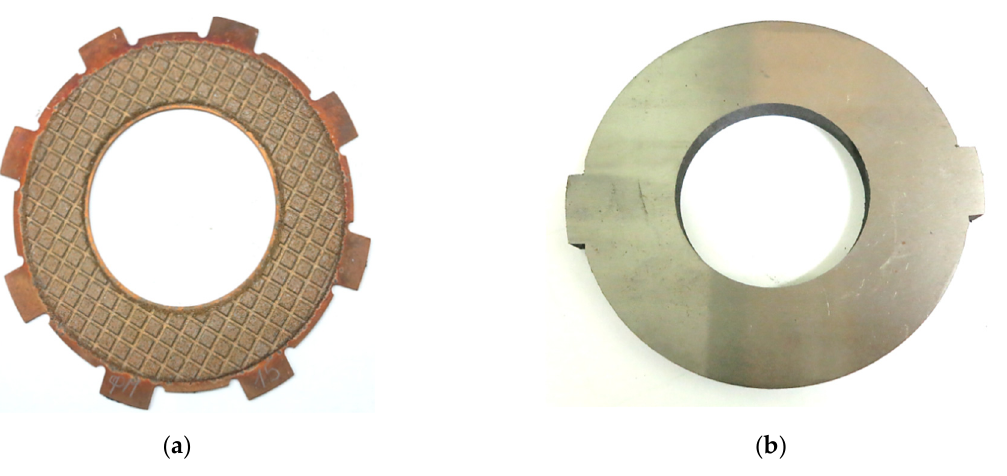
Figure 3. Clutch elements: ( a ) friction disc; ( b ) steel disc-counter body